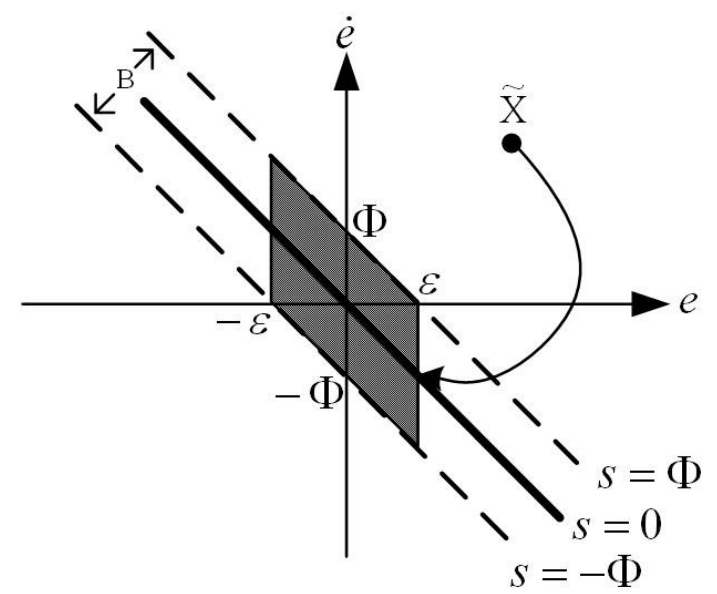
Figure 1. The definition of boundary layer for a sliding surface